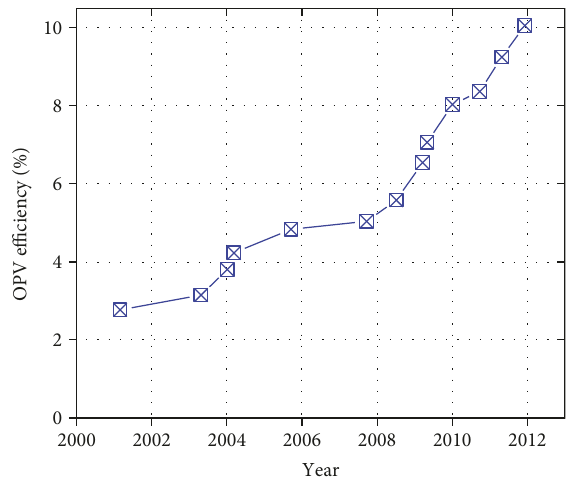
Figure 2: Yearly developments of laboratory organic solar cell PCEs [23 –